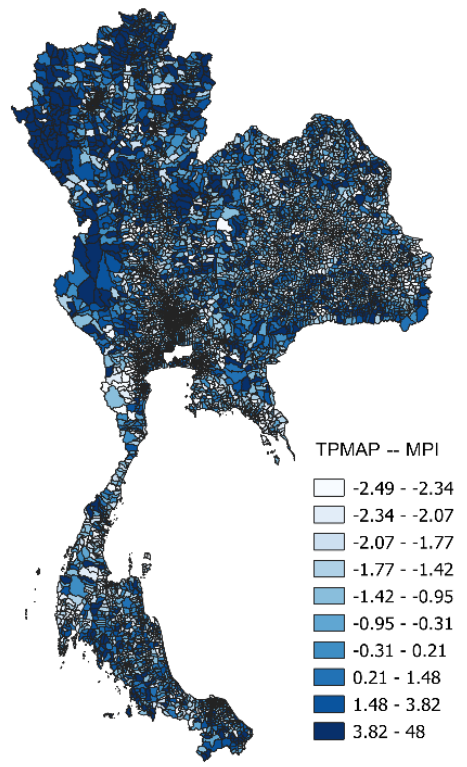
Figure 9. Spatial distribution of MPI (from TPMAP data) in 2017. Source: NESDC.